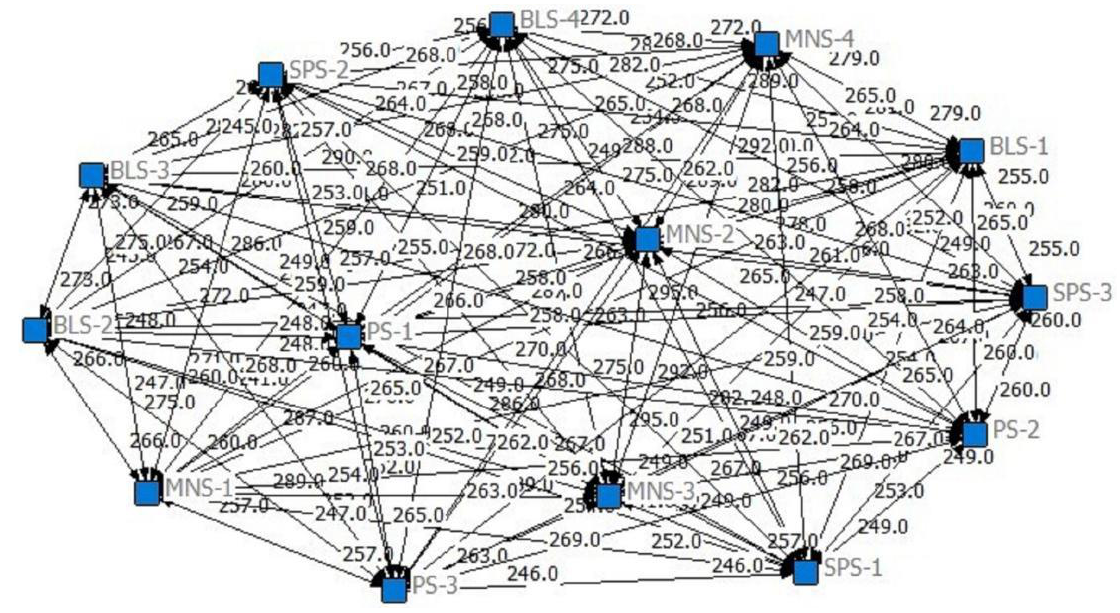
Figure 1. Relationship networks between the inadequately met care needs of the disabled elderly.